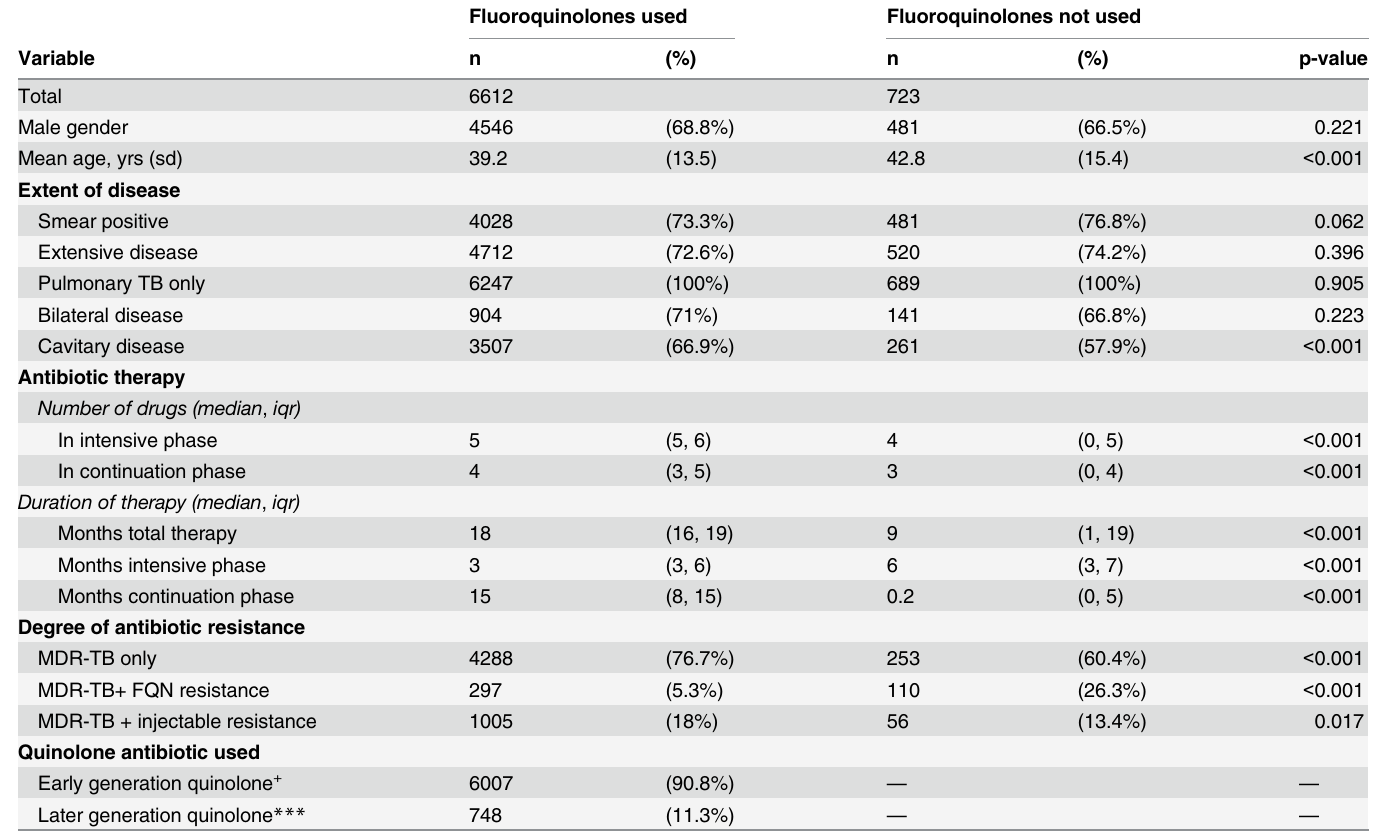
Table 1. Characteristics of study participants, according to whether fluoroquinolone antibiotics were used.